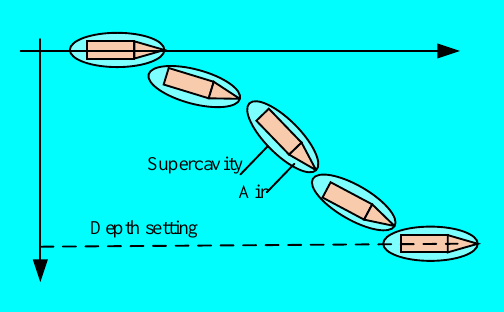
Figure 2. The schematic diagram of the SV depth tracking without planing